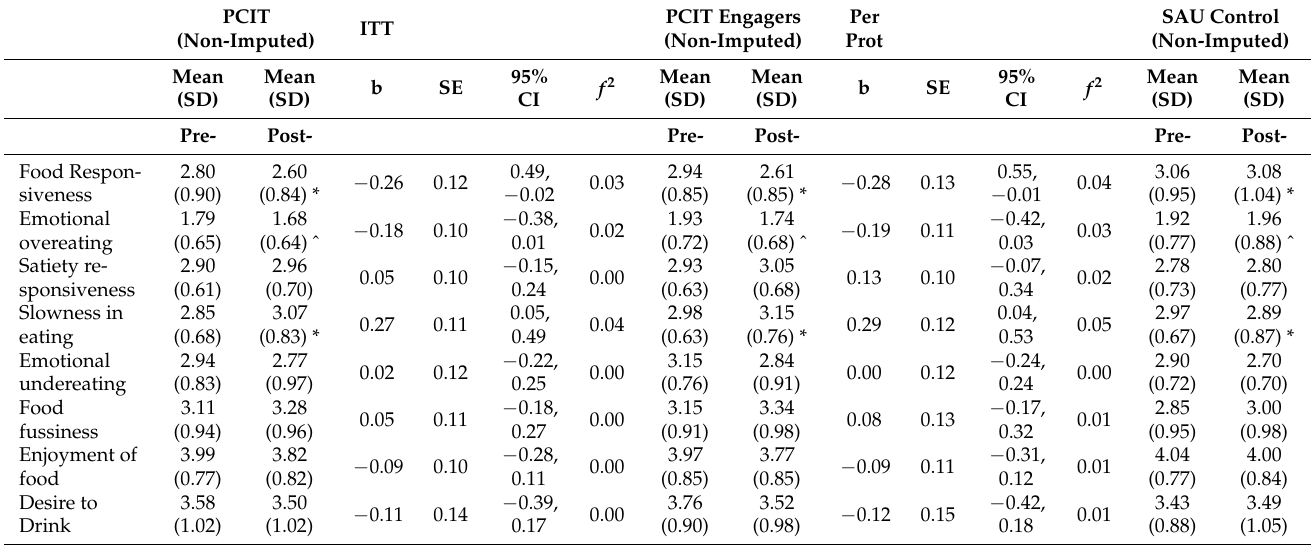
Table 2. Effects of Parent–Child Interaction Therapy (PCIT) on children’s post-treatment eating behavior outcomes after accounting for the pre-treatment